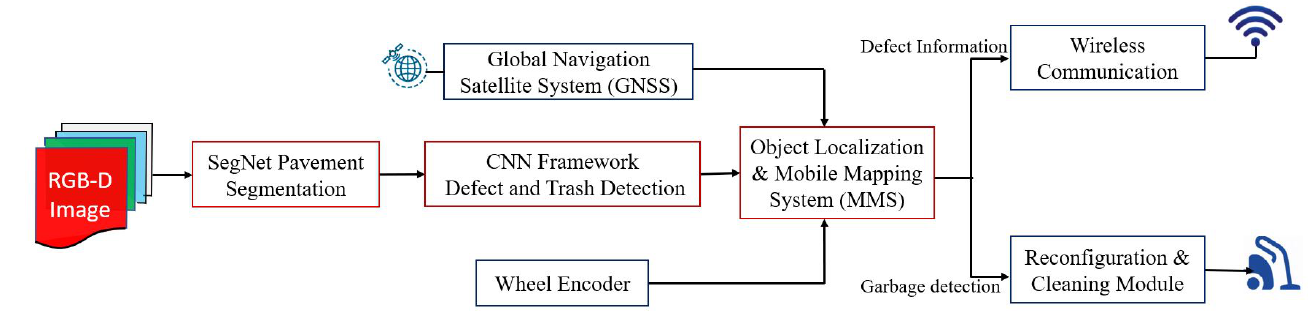
Figure 5. Pavement defects and cleanness inspection framework.